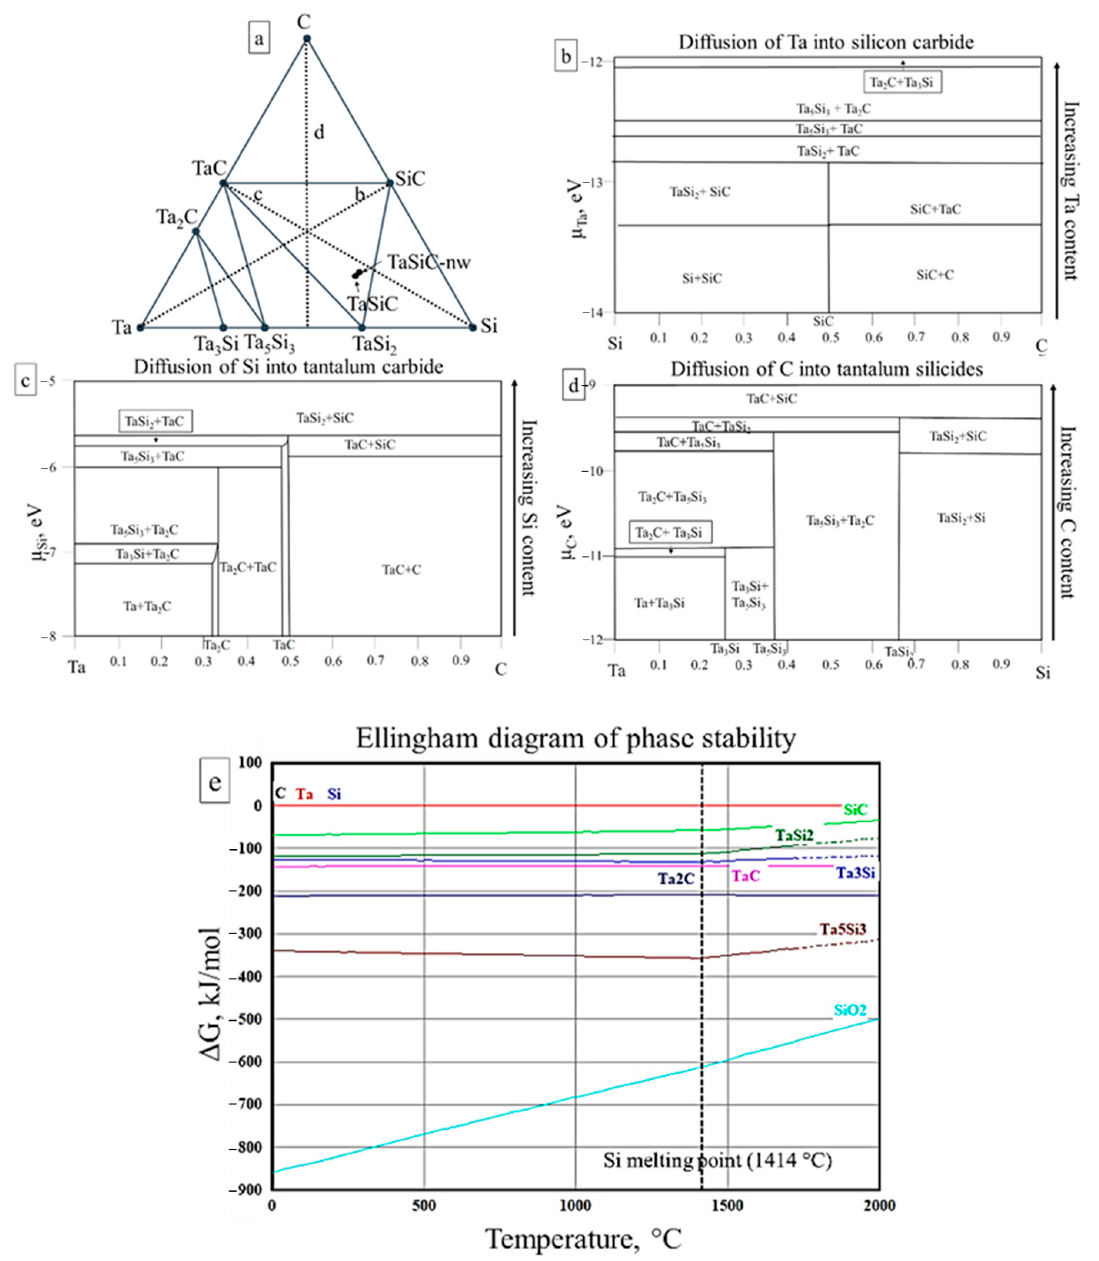
Figure 2. Ab initio calculated isothermal section (0 K) of Ta-Si-C phase diagram ( a ); Grand potential phase diagrams assuming Ta ( b ), Si ( c ), and C ( d ) as an open element/principal diffusor; ( e ) Ellingham diagram of phase stability in the Ta-Si-C system .